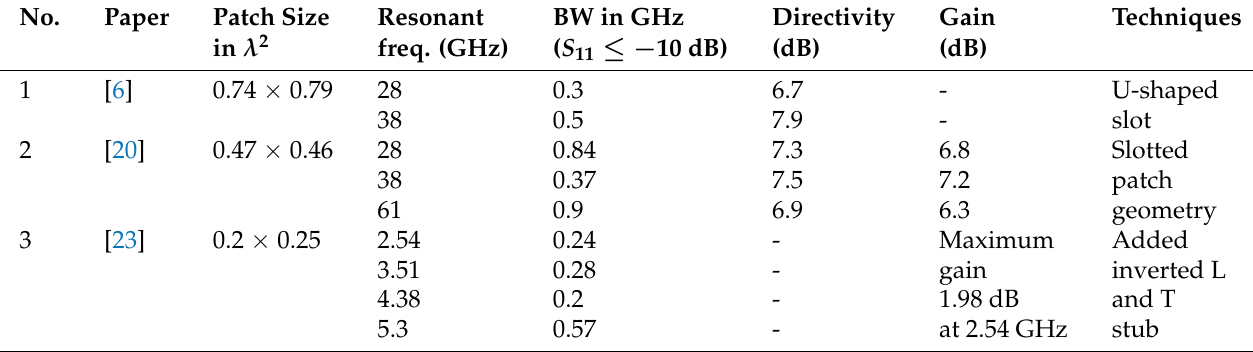
Table 2. Performance comparison of the proposed antenna with other mm-wave